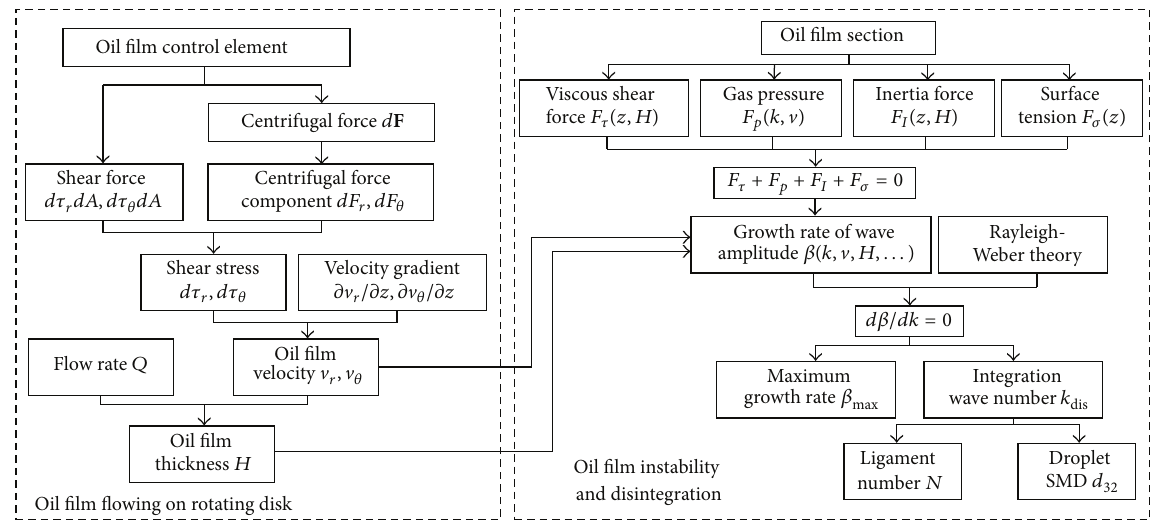
Figure 3: Calculation scheme for the theoretical